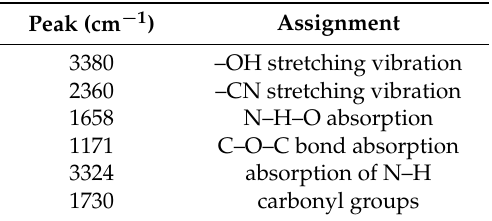
Figure 5. Side SEM of F. mandshurica veneer after reactive red dyeing at different concentrations of ( A ) 0.5% and ( B ) 3.0%.